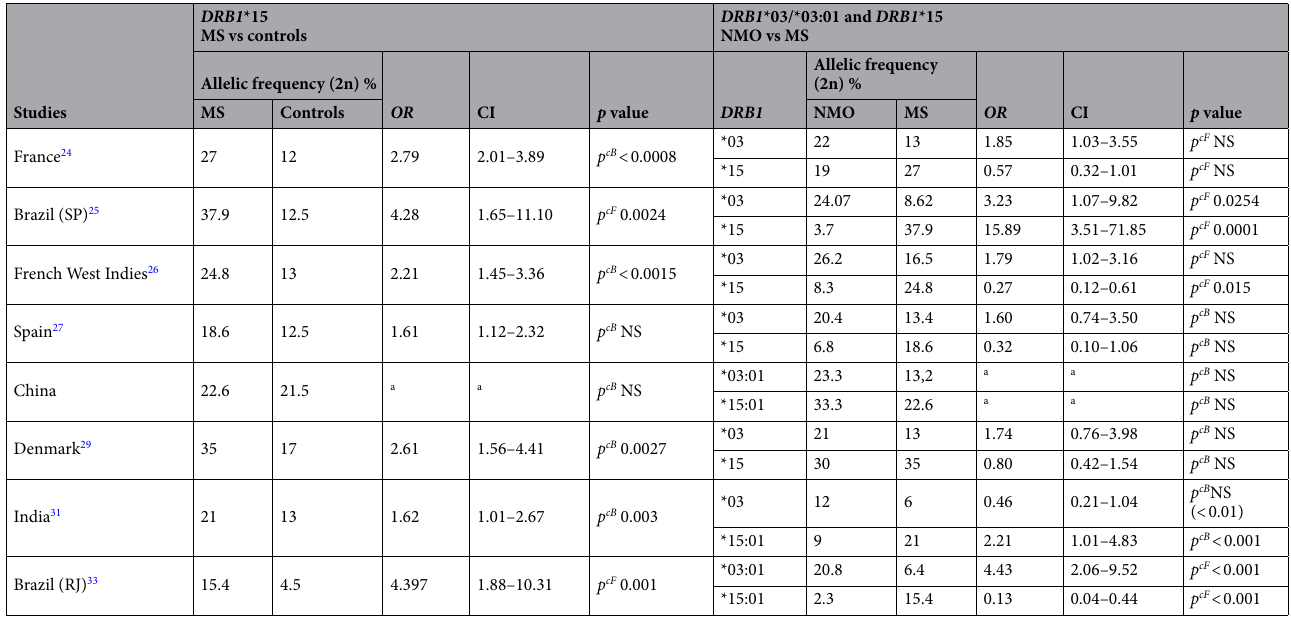
Table 5. Susceptibility in MS and comparison of NMO and MS groups regarding frequency of DRB1 *15 and DRB1 *03 allelic groups. MS, Multiple Sclerosis; NMO, Neuromyelitis Optica; OR , Odds Ratio ; CI, Confidence Interval; p cF , p corrected by Fisher’s exact test; p cB , p corrected by Bonferroni method; NS, not significant. a Data not